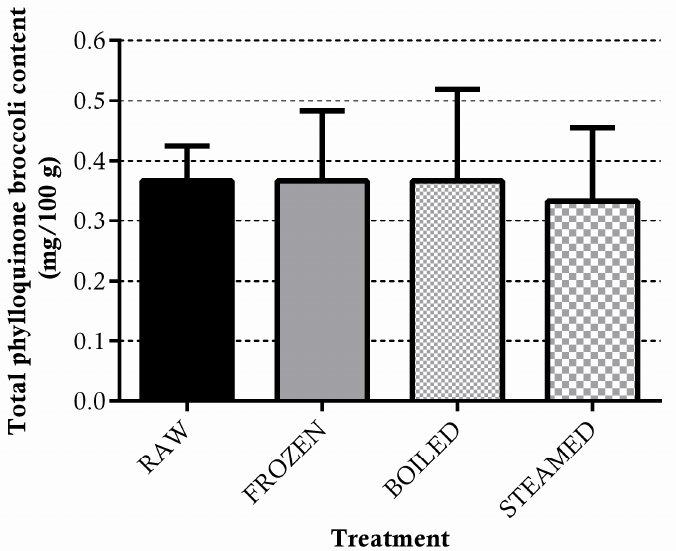
Figure 2. Total phylloquinone levels in raw, frozen ( − 20 °C for 15 days) boiled and steamed broccoli. Data are expressed as mg/100 g of fresh vegetables ± SD of five cooking replicates.